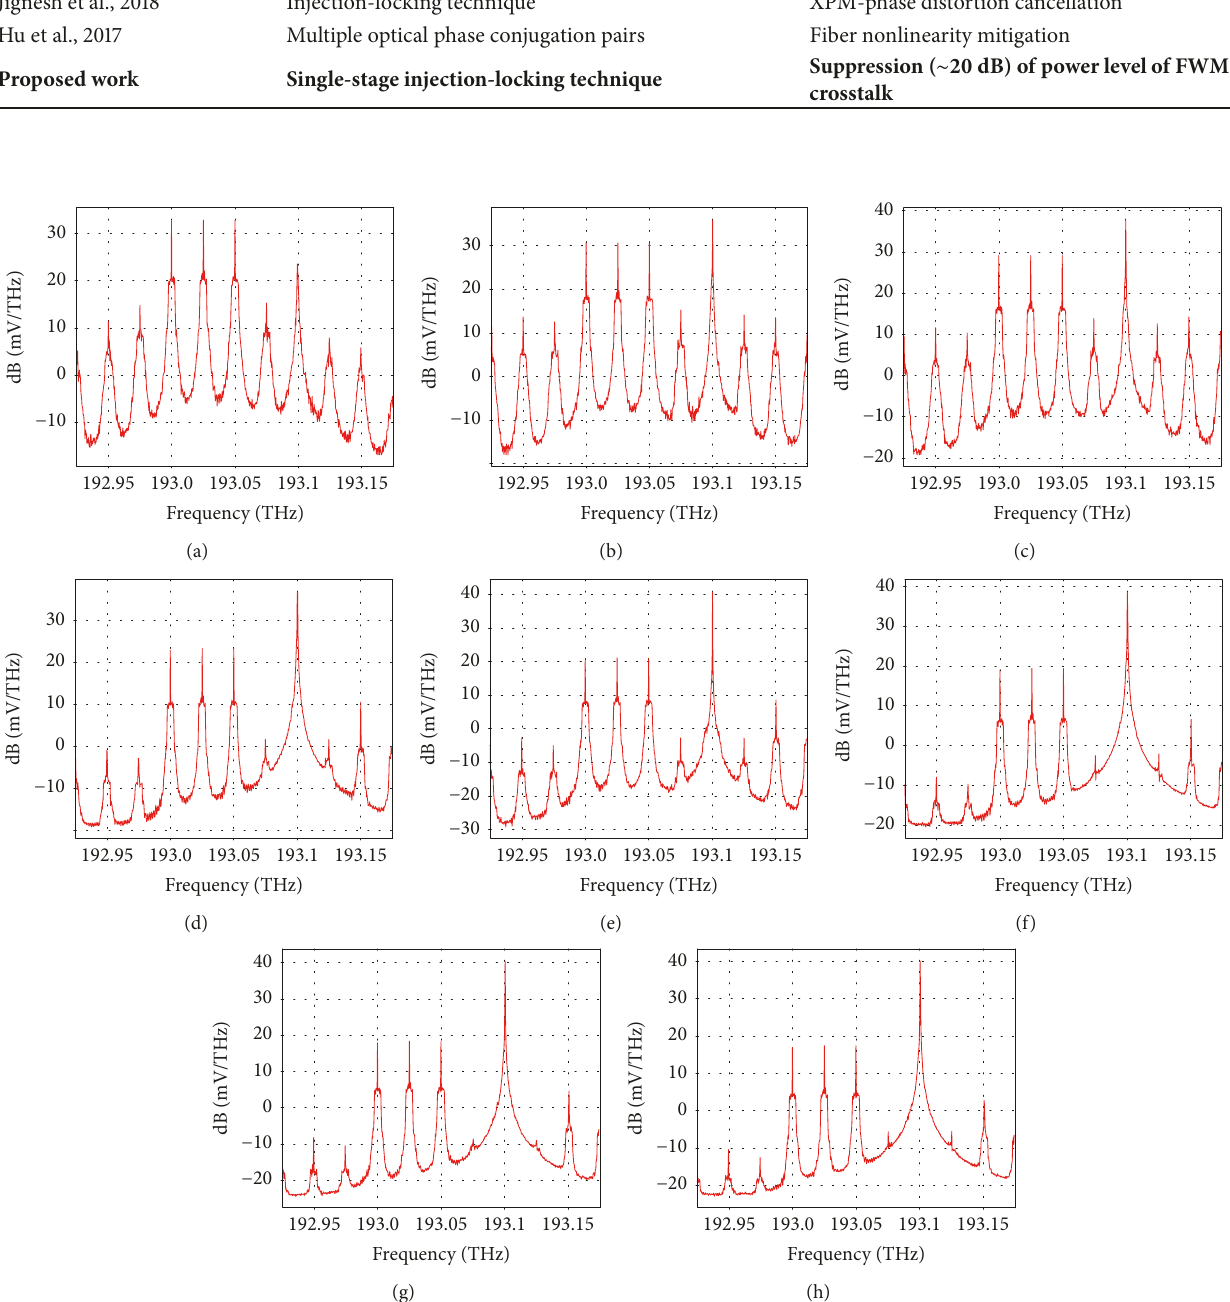
Figure 4: Received optical spectra with significant FWM crosstalk products as a function of bias current of slave laser: (a) 8 mA, (b) 9 mA, (c) 10mA, (d) 20mA, (e) 30mA, (f) 40mA, (g) 50mA, and (h)